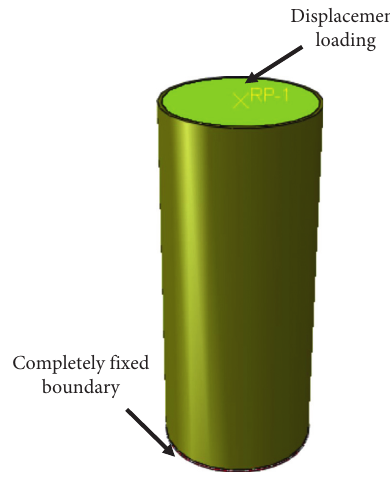
Figure 9: Boundary